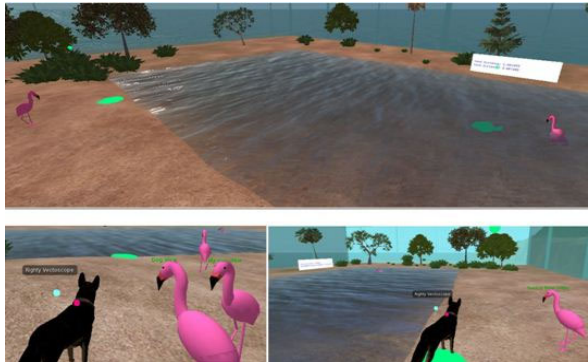
Figure 1. Simulated in the Second Life VE interactive